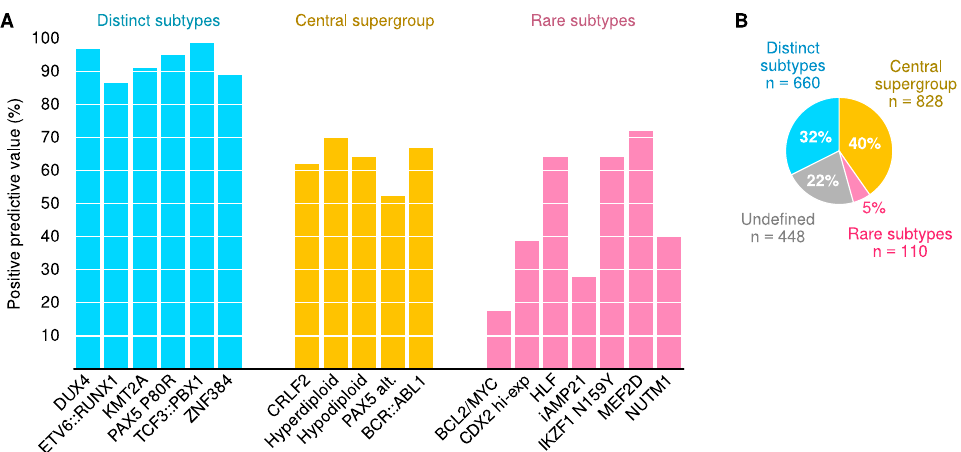
Figure 6. Classification performance of the Allspice centroid classifier. ( A ) The bars show positive predictive values for all samples including those with undefined genetic subtypes. They represent conservative estimates on how likely it is that the subtype predicted by RNA-seq expression levels can be confirmed as a specific sequence alteration or is also indicated by cytogenetics. ( B ) Propor- tions of genetic subtypes in the dataset. Table 2. Positive predictive values for correct classification into genetically defined B-cell ALL sub- types. The values are presented as the percentages of samples for which the best matching RNA centroid was the same as the genetic subtype if defined. Quality control was set at ≥ 50% proximity and ≥ 50% exclusivity (details in Methods).